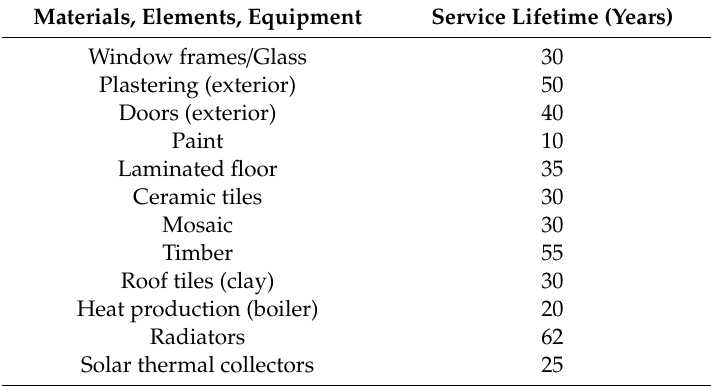
Table 2. Service lifetime in years of common building materials, elements, equipment, and